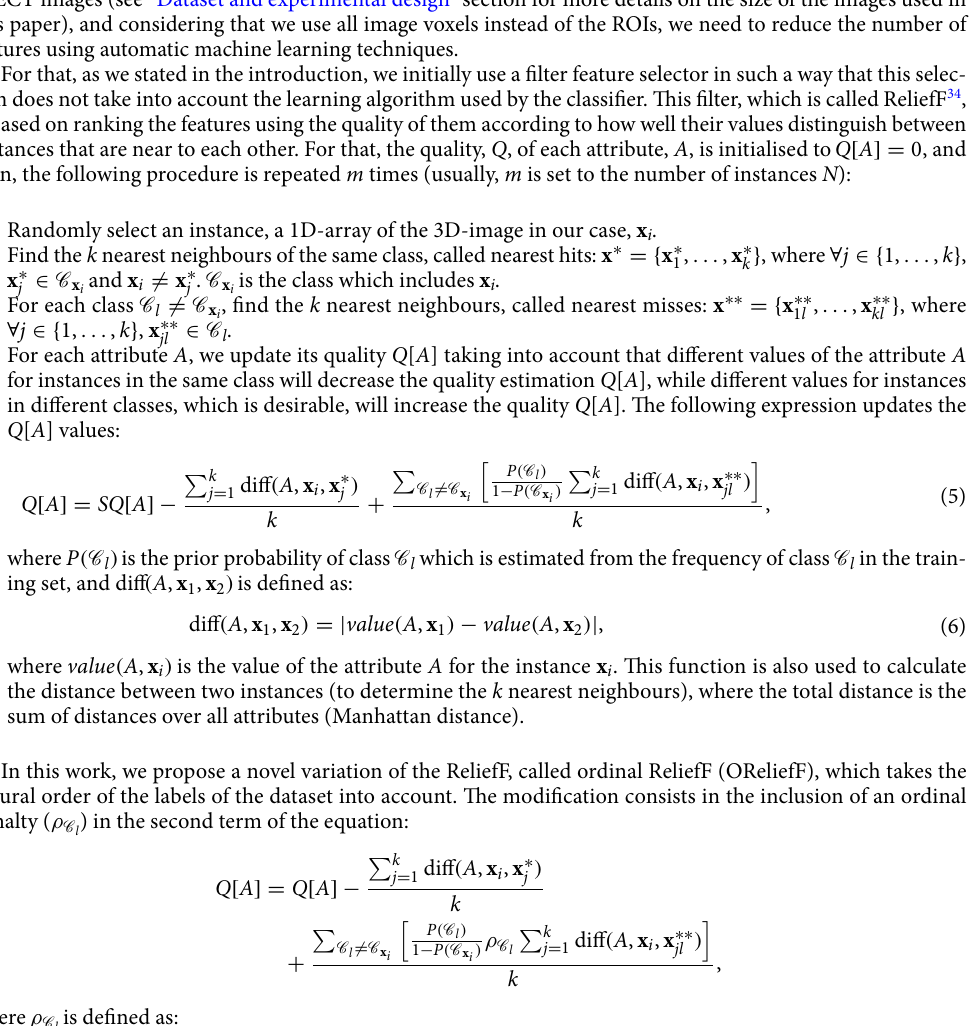
2 3 reshaped to a × ×